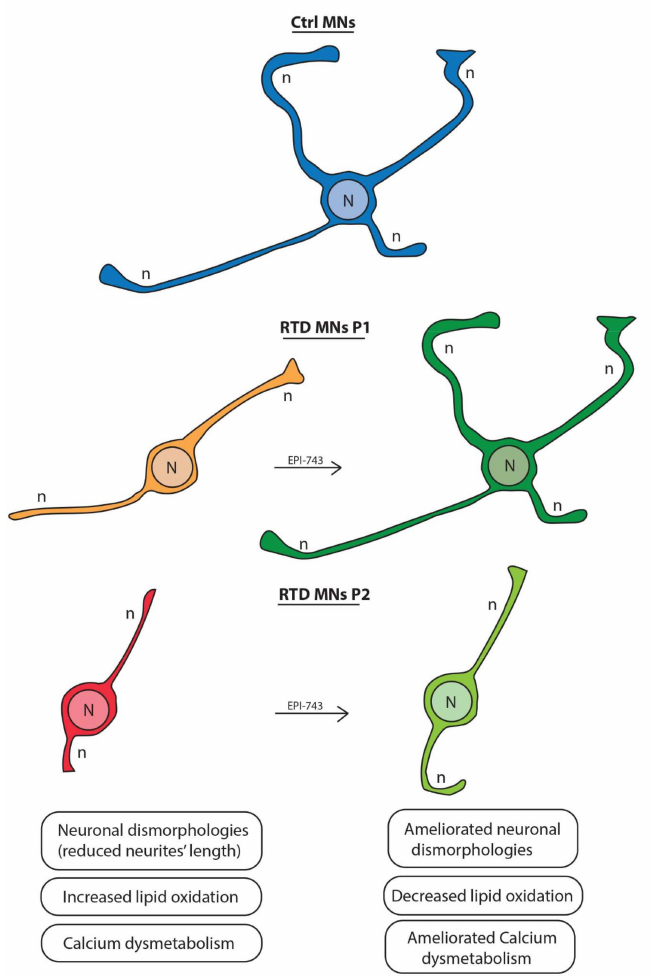
Figure 5. Schemae showing the morphological changes of the RTD MNs before and following treatment with EPI-743. The drawing depicts neurons with short neurites in RTD P1 and P2, but following EPI-743 treatment they extend longer neurites that, for RTD P2, are very similar to Ctrl MNs, while, for RTD P1 neurite length is improved but still not comparable to that of Ctrl MNs. N = Nucleus. n =